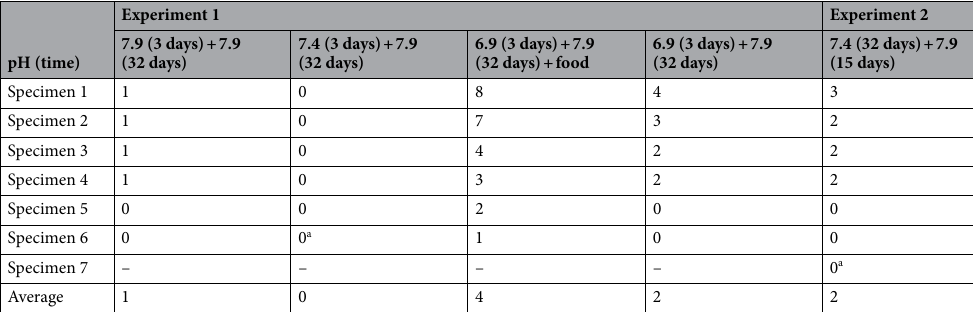
Table 2. Number of chambers added by Peneroplis spp. specimens during the recovery phase for both experiments. a Specimens that died during that phase.